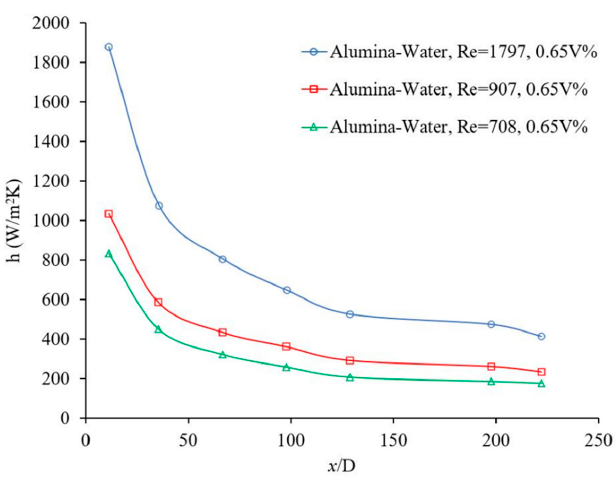
Figure 3. Effect of Reynolds number on heat transfer coefficient, Rea et al. [14].